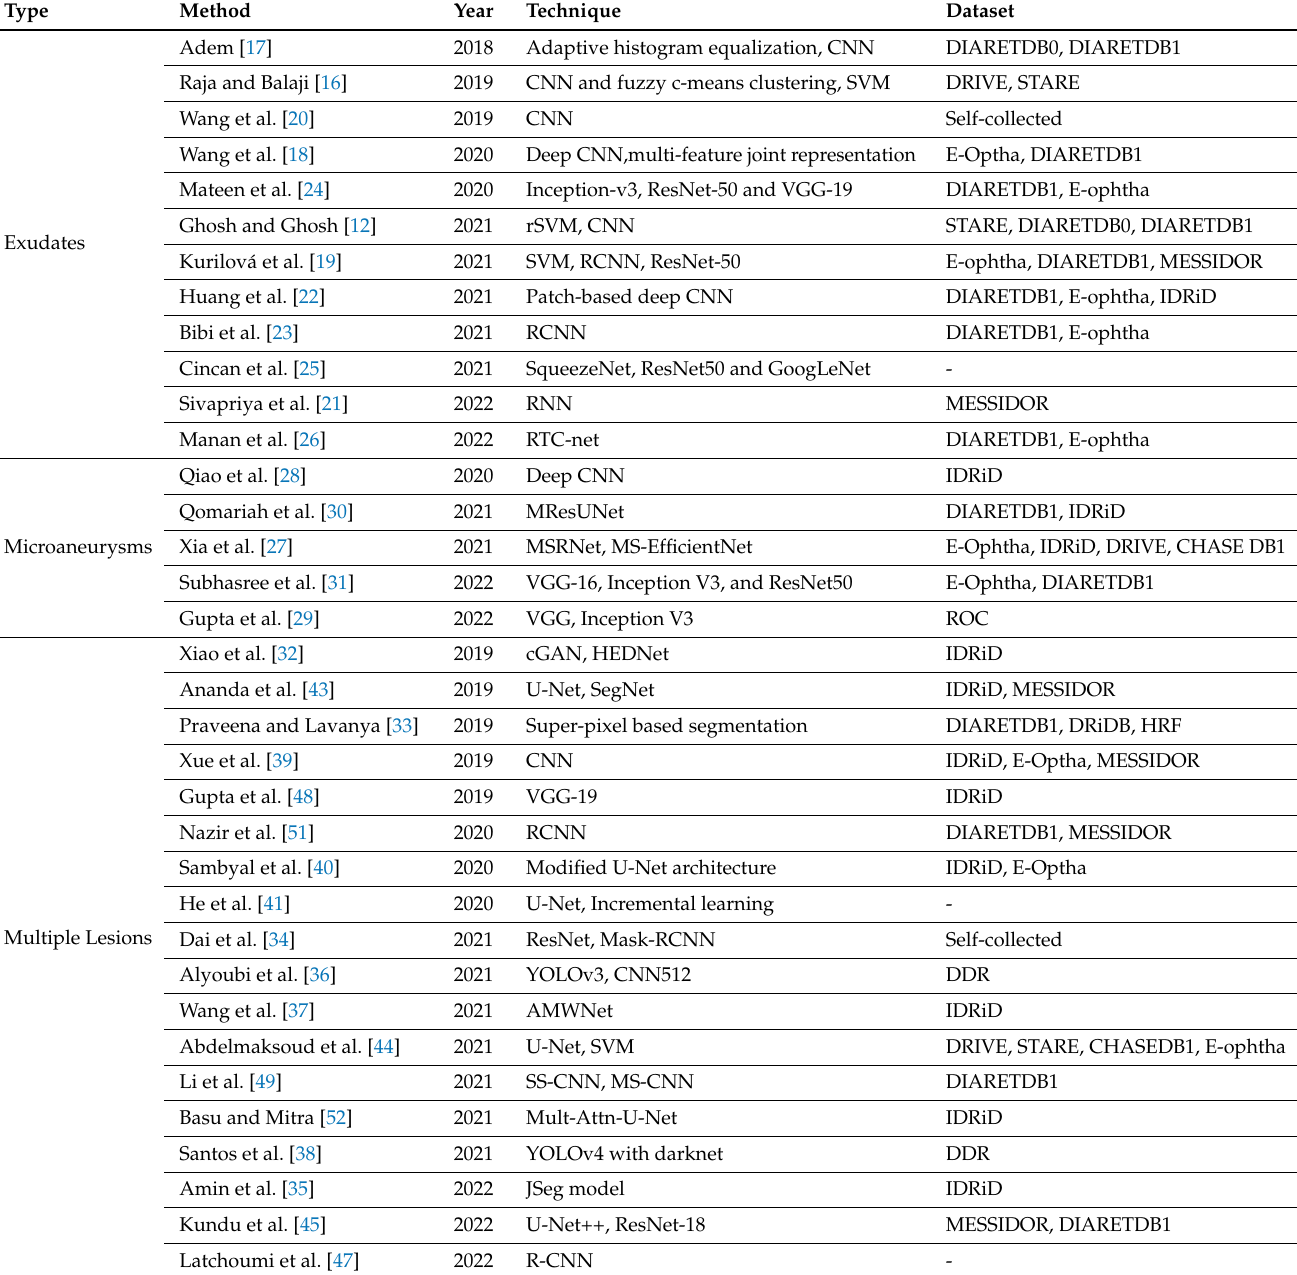
Table 1. Deep Learning based approaches for diabetic retinopathy lesion